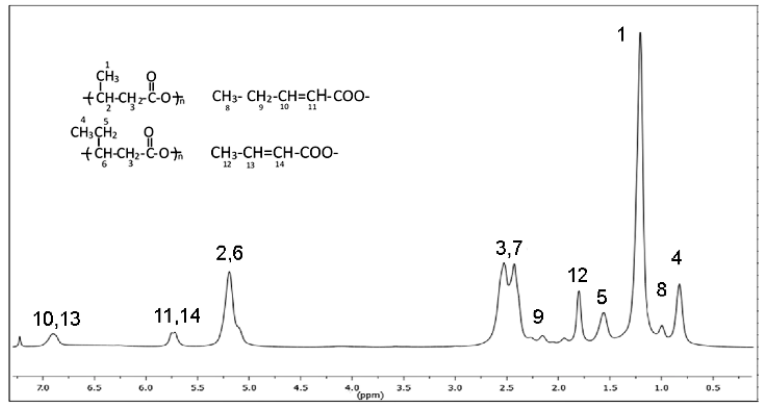
Figure 6. 1HNMR of PHA extracted at 150 °C for 1 h and assignments of the peaks.